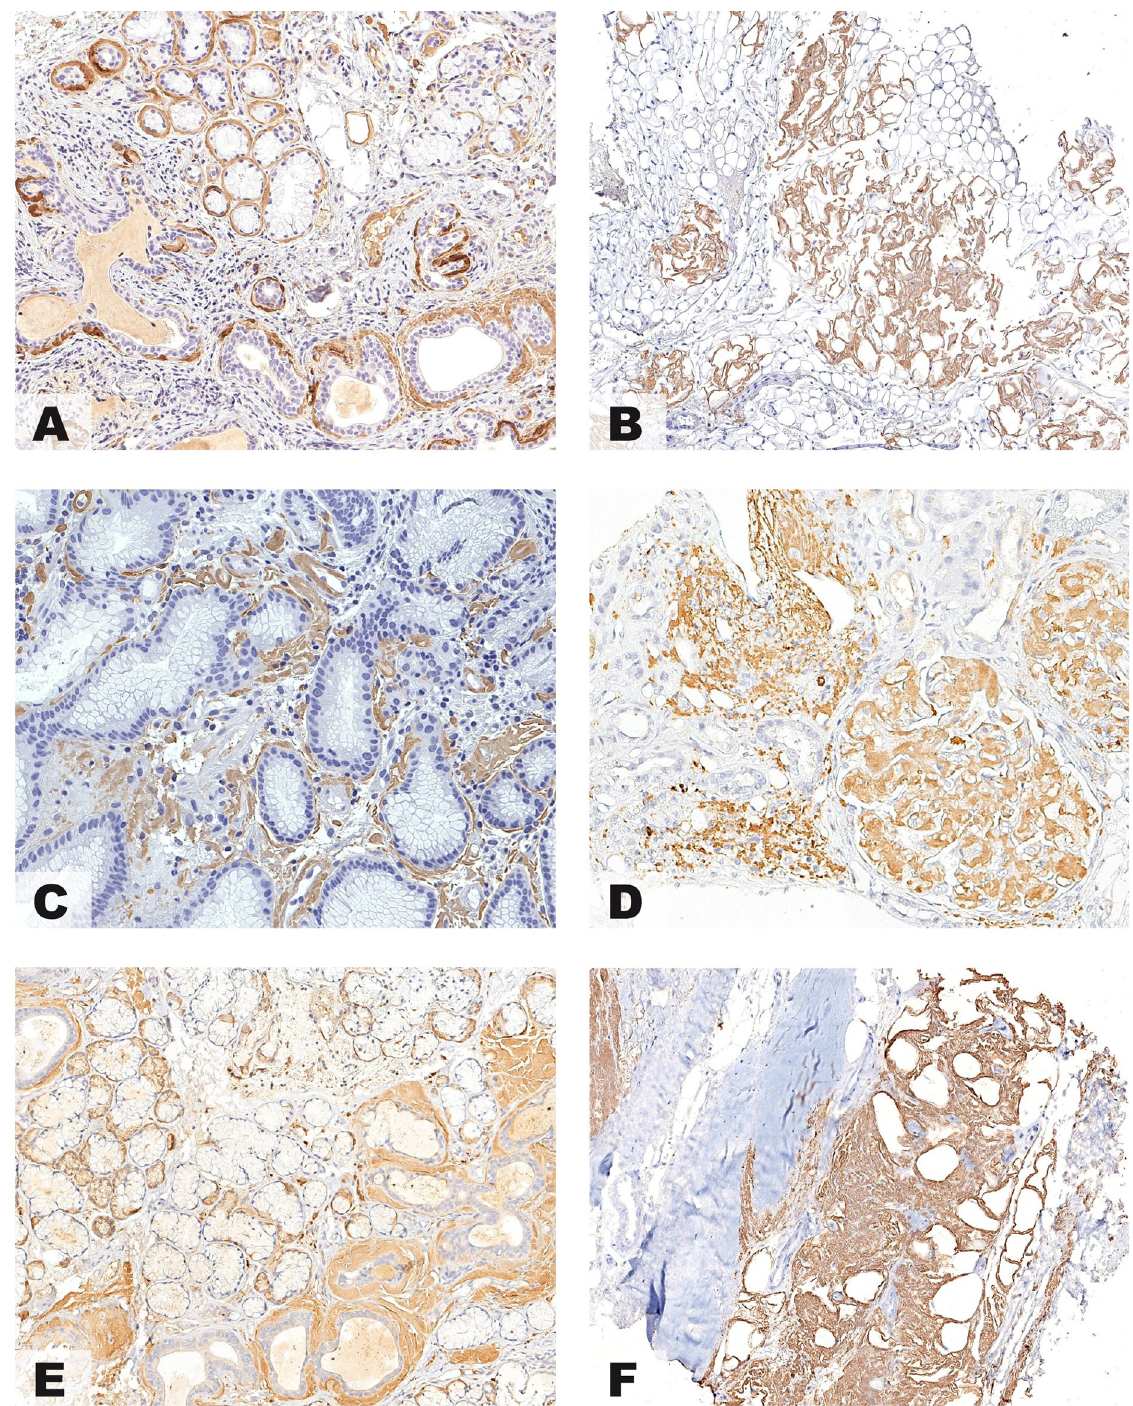
Fig 2. Immunohistochemistry of amyloid deposits. Minor salivary glands biopsy detected areas of amyloid substance in periductal and periacinar location that stained strongly only for anti-AL λ (ULI-LAT) (A, x200). Periumbilical fat biopsy in an 80-year-old male demonstrated a septal and vascular pattern of amyloid deposition that resulted brightly positive only for anti-ATTR (TIE) (B, x200). Antral gastric biopsy revealed interstitial and vascular amyloid deposits that were strongly positive only for anti-AA (red clone) (C, x200). Renal biopsy demonstrated glomerular and interstitial amyloid deposition with bright positivity for anti-ALk (KRA/KUN) (D, x200). Minor salivary glands biopsy detected, in this 42-year-old female, amyloid deposits located in the interstitium and around ducts which turned out to